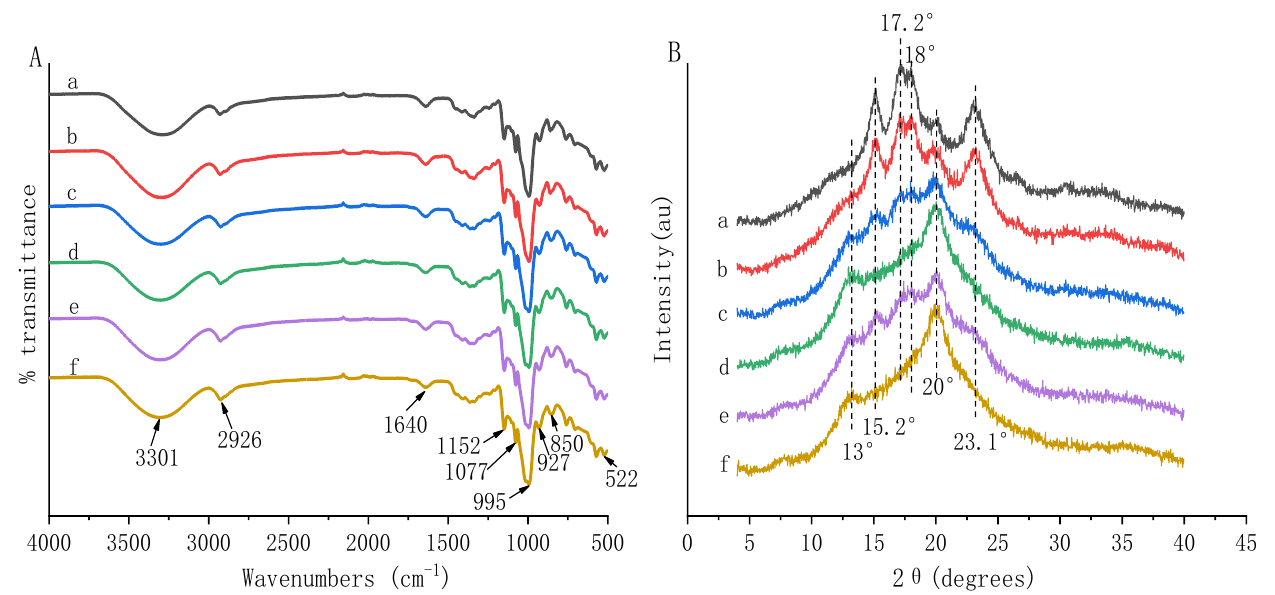
Figure 1. Infrared spectra ( A ) and X-ray diffraction pattern ( B ) of highland barley polyphenol-starch complexes extracted with different solvents. (a) Amylose; (b) Highland barley starch (HBS); (c) 80% methanol extracted highland barley polyphenols (MHBP)-amylose complexes; (d) 80% acetone extracted highland barley polyphenols (AHBP)-amylose complexes; (e) 80% methanol extracted highland barley polyphenols -highland barley starch (MHBP-HBS) complexes; (f) 80% acetone extracted highland barley polyphenols-amylose complexes (AHBP-HBS) complexes.